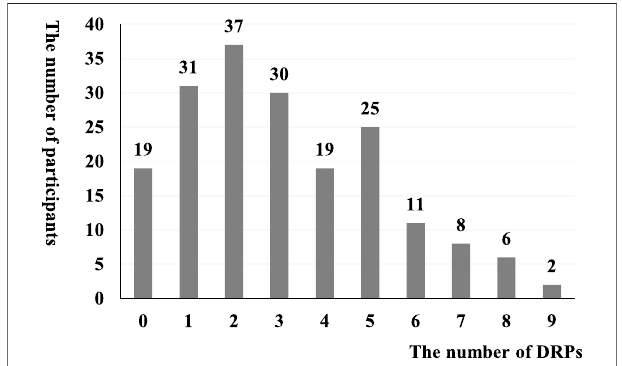
FIGURE 1 | The number distribution of DRPs in children with chronic diseases in the PHCI.